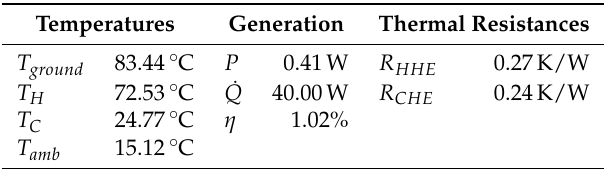
Table 3. Average temperatures, generation and thermal resistances of M2 during 19 May 2020 between 11:00 and 20:00